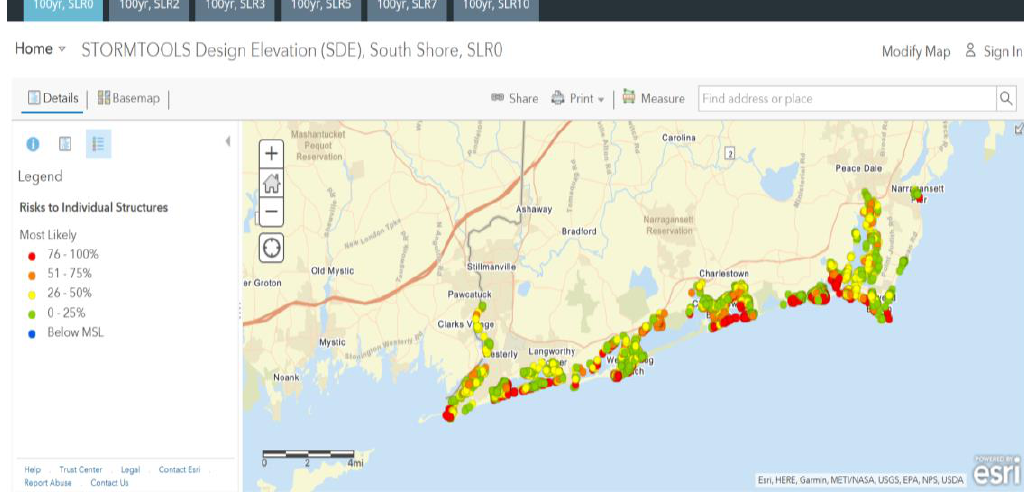
Figure 6. CERI predicted damage for the 100 yr surge, no SLR case for the most likely damage estimates. (CERI results are available for all SLR cases at: https://crc-uri.maps.arcgis.com/apps/MapSeries/index.html?appid=2a4ab310fecc4721935287e5a5f7ace4) accessed on February 13, 2020).